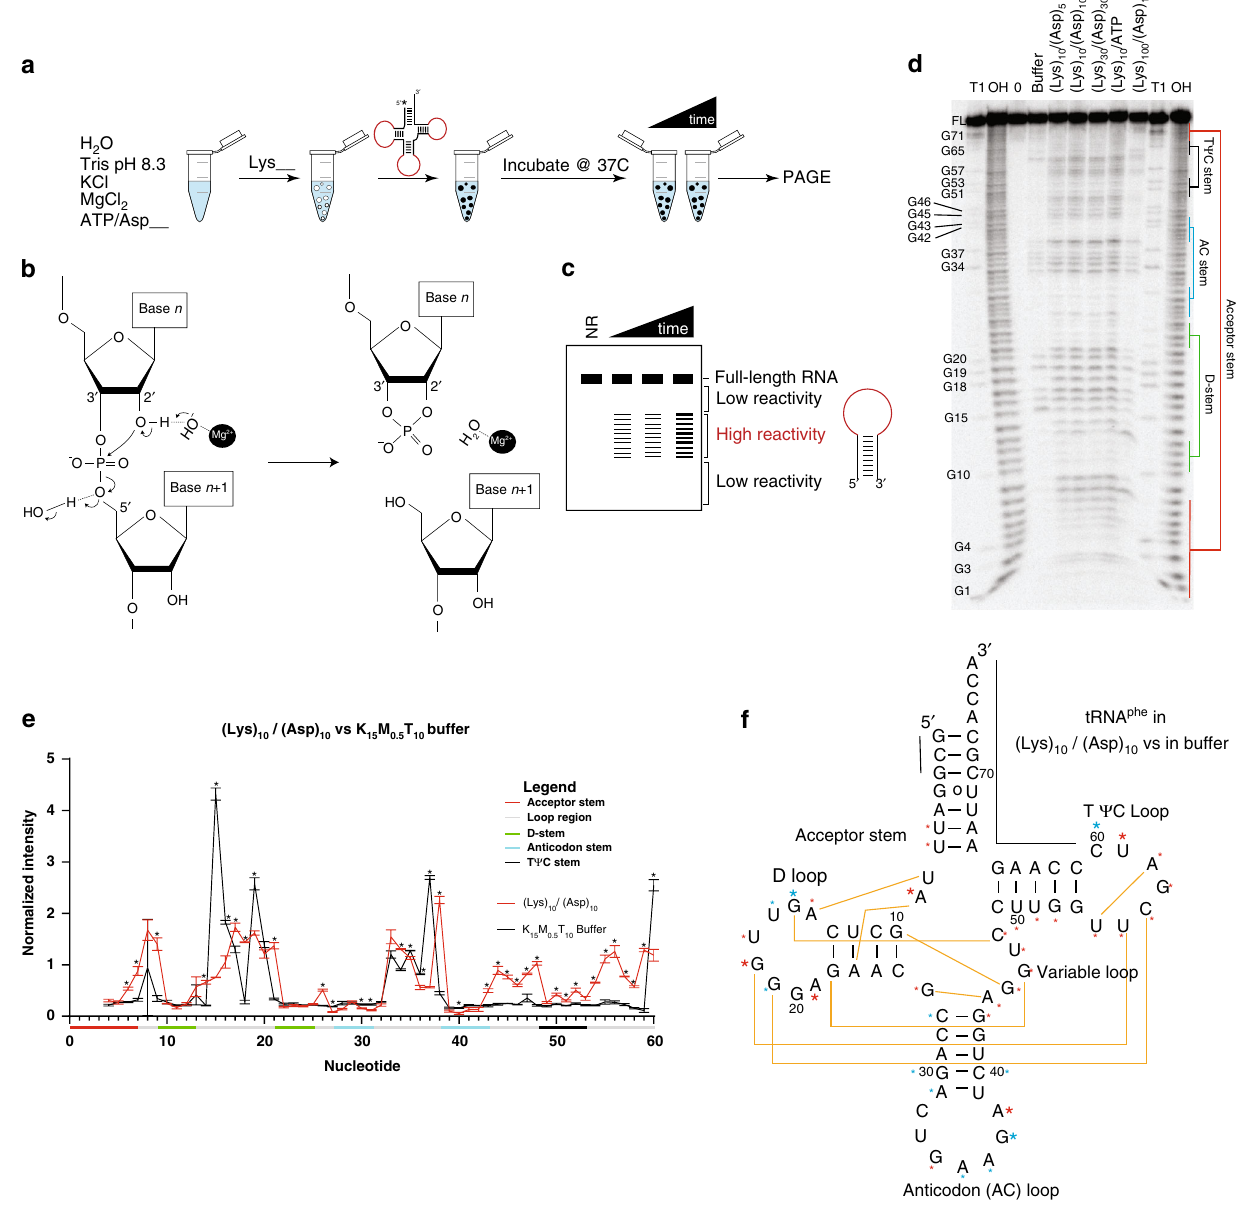
Fig. 6 Analysis of RNA structure in coacervates by in-line probing (ILP). a ILP sample pipeline. Coacervates are formed, 5 ’ -end radiolabeled RNA is added and incubated, and samples are fractionated by PAGE. b Mechanism of ILP strand cleavage of RNA involving deprotonation of the 2 ’ OH by metal-bound hydroxide. c ILP reactivities of radiolabeled RNAs can be read out on denaturing PAGE. d Denaturing polyacrylamide gel for ILP of tRNA phe in all solution conditions tested, with RNase T1 “ T1 ” , base-hydrolysis “ OH ” , and time 0 “ 0 ” control lanes. (Image was cropped at G1 (bottom of gel) and Full Length (FL) (top of gel), and at the left and righthand sides of the gel to remove lanes not relevant to this experiment). e Overlay line plot of (Lys) 10 -(Asp) 10 and polyion-free control demonstrating that tRNA phe has its tertiary structure unfolded in coacervates. Raw band intensities were quanti fi ed from gels, and normalized intensity values were generated by taking the average raw intensity at nucleotides 34 – 36 in the anticodon loop and dividing each raw intensity by this average value. Multiple t -tests were performed with one at each nucleotide and the Holm – Sidak method was used to correct for multiple comparisons. Points were considered statistically signi fi cant if their p value was less than alpha = 0.05. Error bars show standard deviation of measurements over at least three independent samples. f Secondary structure of tRNA phe , with data from panel e superimposed. Yellow lines indicate tertiary contacts. Black lines at top of fi gure indicate nucleotides without data. Asterisks indicate signi fi cant p values, with blue indicating a decrease in reactivity upon going from buffer to coacervate, and red indicating an increase. Larger red and blue asterisks indicate those nucleotides with signi fi cant p values and a difference between the two conditions of at least 1 or − 1 in arbitrary units of Normalized